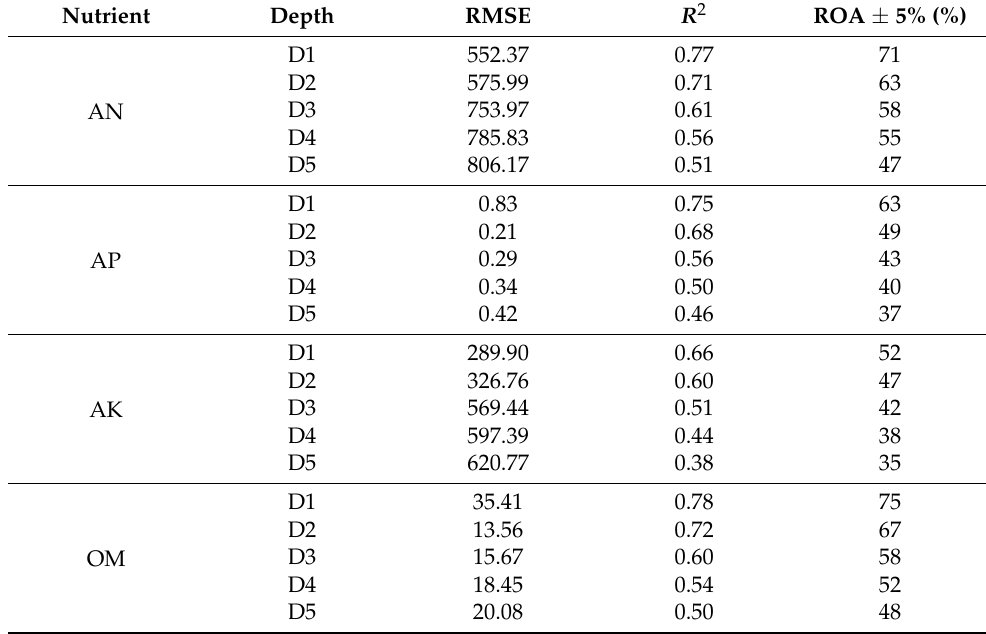
Table 4. The optimal accuracies of remote sensing ANN model (Model C) of soil